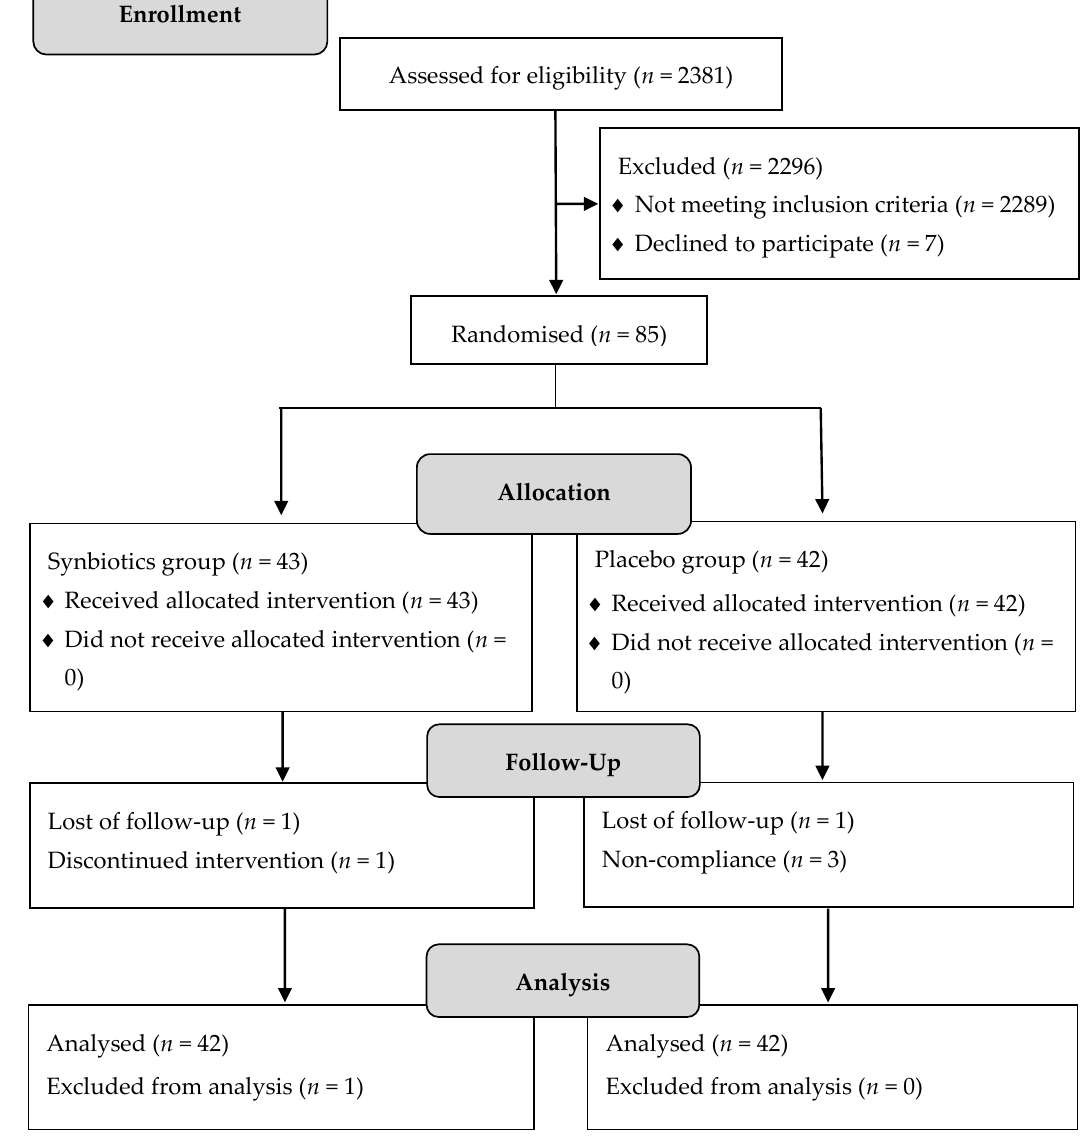
Figure 1. Consolidate standards of reporting trials (CONSORT) flow diagram of participants.